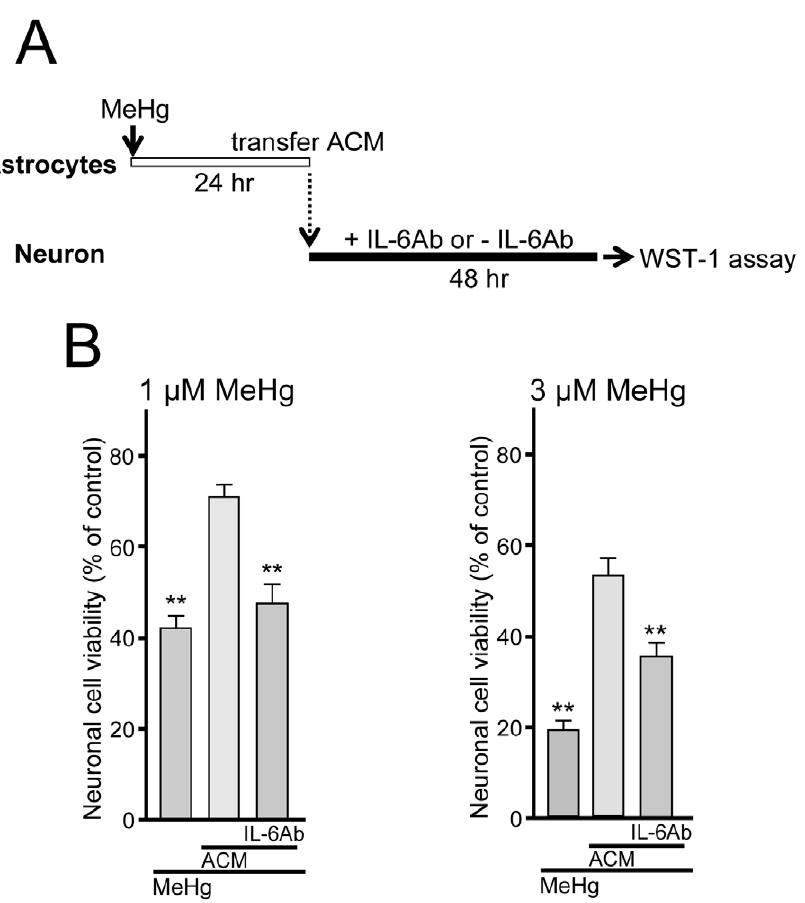
Figure 5. Neuro-protection by astrocyte-derived IL-6. ( A ) The experimental schedule. MeHg (1 or 3 m M) was treated to the astrocyte culture for 24 h and the ACM was transferred into the neuronal culture. The ACM-treated neuronal cultures were further incubated for 48 h with or without IL-6 antibody. ( B ) ACM restored the reduction in neuronal viability evoked by MeHg (1 or 3 m M, 48 hr). The ACM-induced neuro-protection against MeHg was significantly reduced by IL-6 antibody (100 ng/ml). **P , 0.01 vs. MeHg.